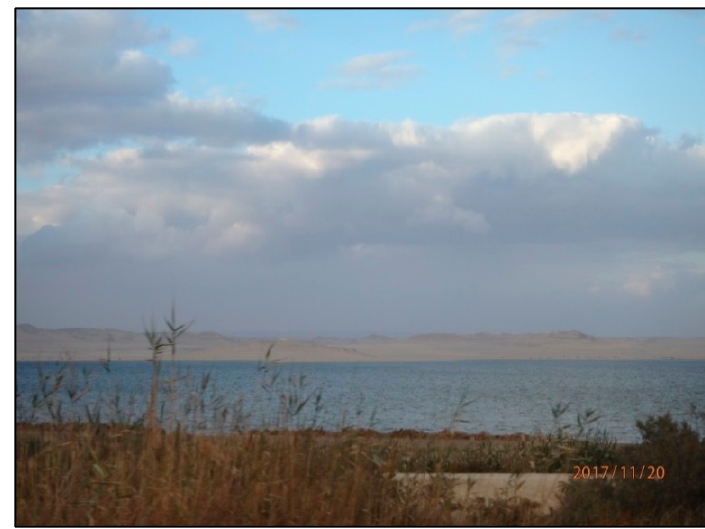
Figure 20. El-Fayyum Lake (photo by M. Salgot).